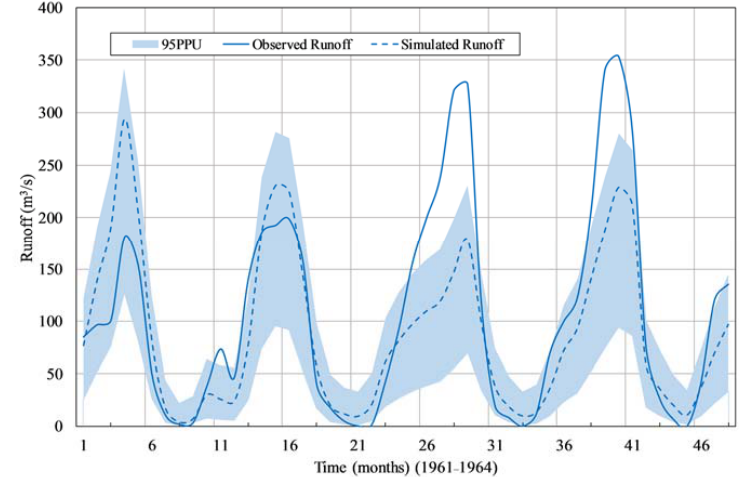
Figure 6. Monthly observed and simulated runoff at the Dokan outlet and 95PPU for the period 1962– Figure 1965.